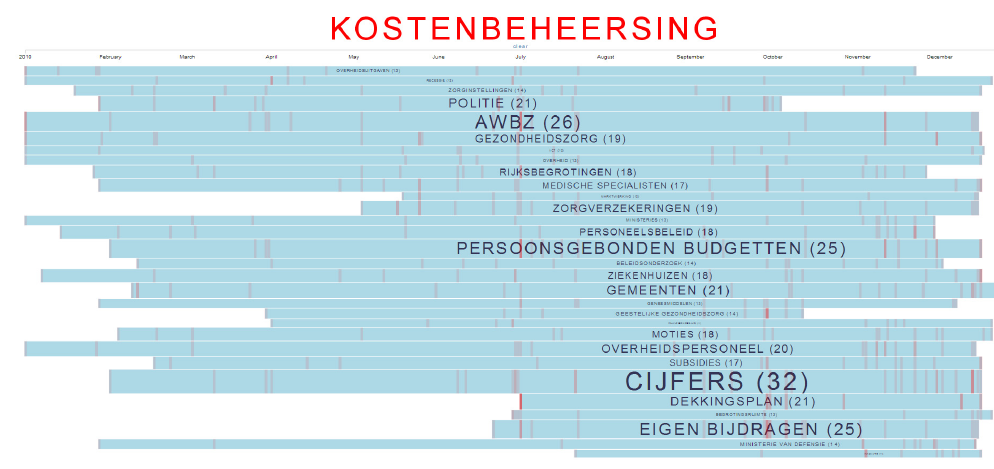
Figure 7. How cost control relates to other topics in